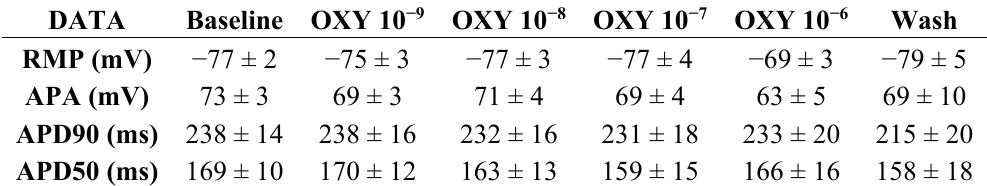
Table 5. In vitro action potential data for